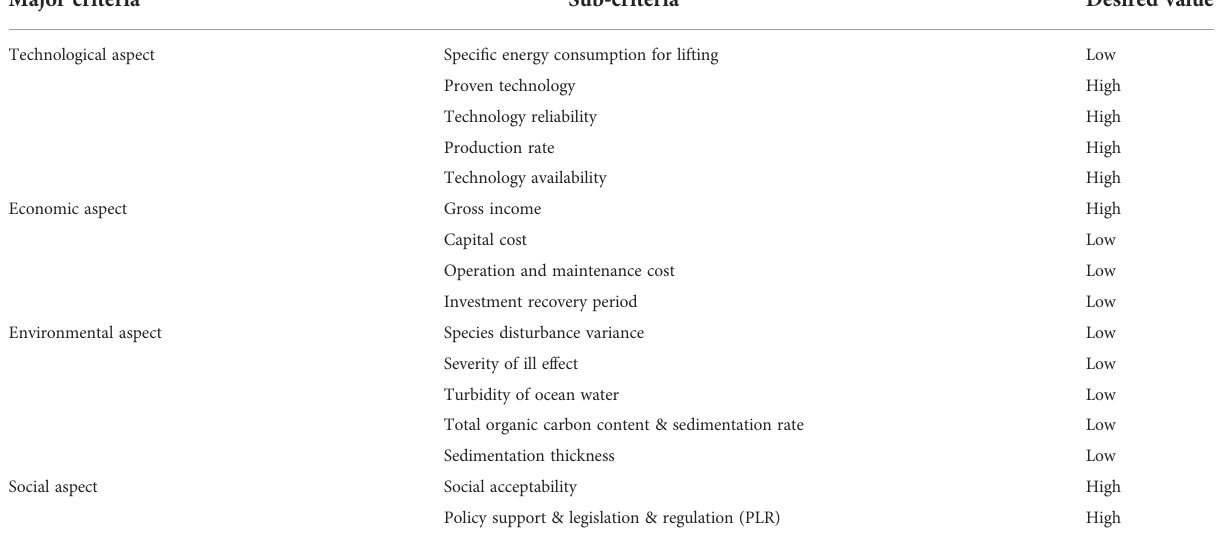
TABLE 5 Preferable or desired value trend for all evaluation criteria.